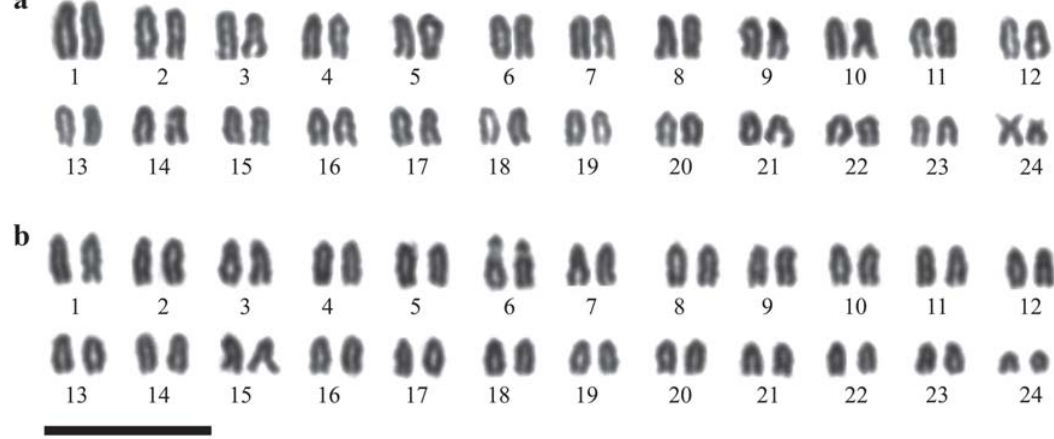
Fig. 1. Giemsa-stained karyotypes of Rhomboplites aurorubens (a) and Ocyurus chrysurus (b). Bar = 10 µ m.